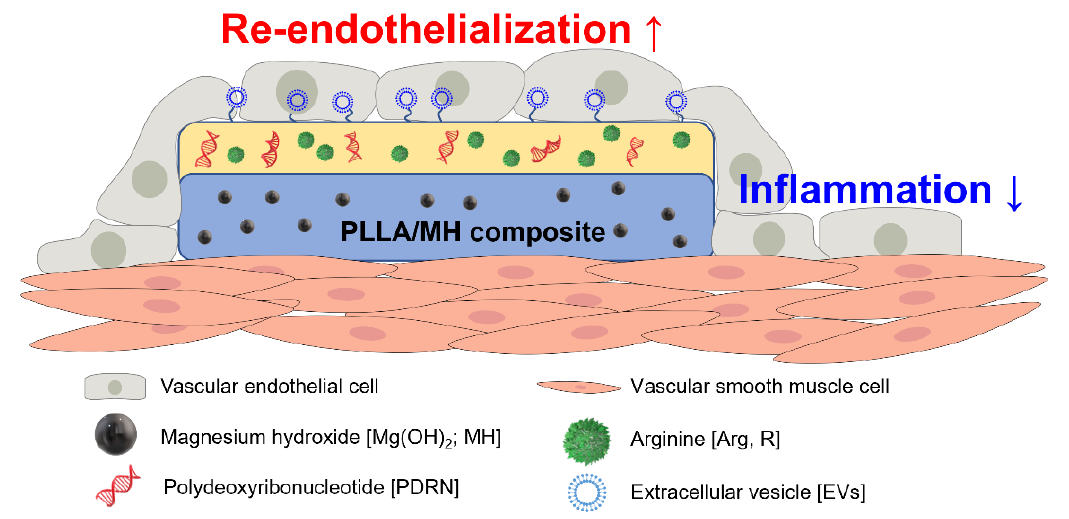
Scheme 1. A schematic illustration of the PLLA composites including MH, PDRN, Arg, and